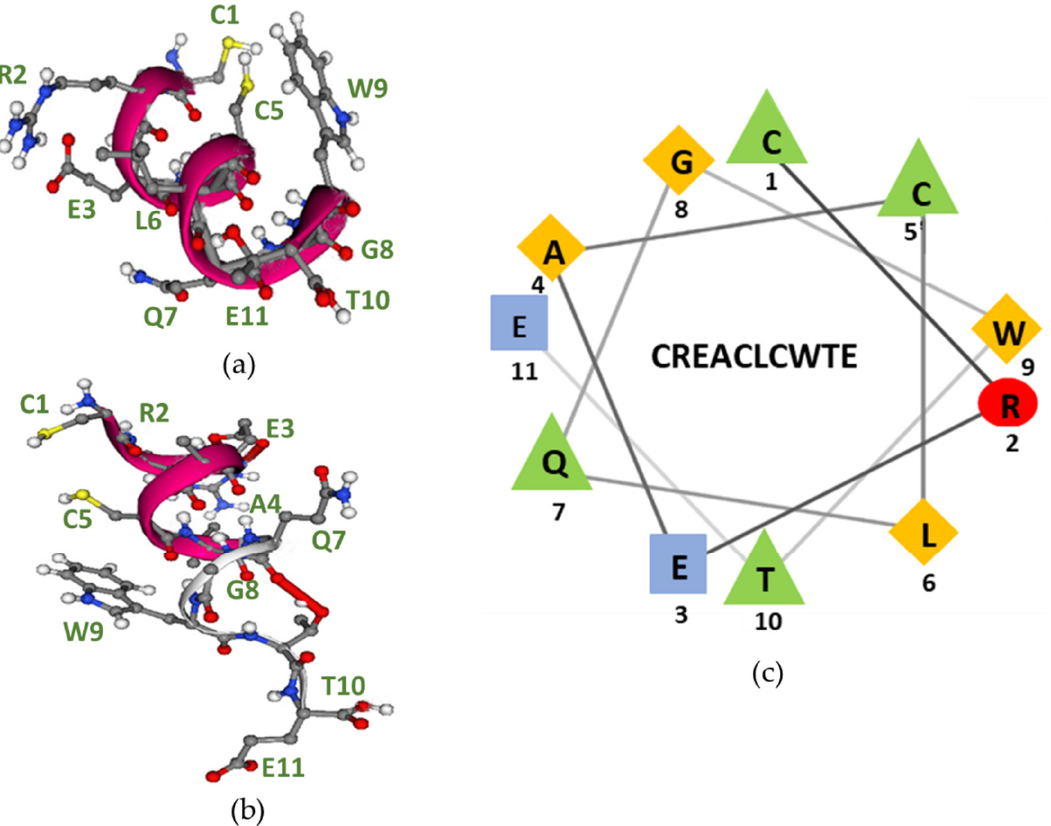
Figure 7. Structural epitope analysis. ( a ) The three-dimensional structure of the CREACLQGWTE sequence obtained from PEP FOLD SERVER. The peptide folds into an α -helix structure in which protruding amino acid residues are seen. On the right side of the structure, the side-chain residues of Trp 9 , Cys 1 , and Cys 5 protrude. On the left side of the structure, the side-chain residues of Arg 2 , Glu 3 , Leu 6 , Gln 7 , and the terminal Thr 10 protrude. ( b ) The three-dimensional structure of the CREACLQGWTE peptide. Yellow balls = sulphur atoms, red balls = oxygen atoms, grey balls = carbon atoms, white balls = hydrogen atoms, and blue balls = nitrogen atoms. ( c ) Helical wheel representation of the CREACLQGWTE peptide. The residues in the epitope are presented using one-letter codes. The image was generated using the NetWheels application (http://lbqp.unb.br/NetWheels, accessed on 14 May 2022). The following colours represent amino acid functions: red, polar/basic; blue, polar/acid; green, polar/uncharged; yellow, nonpolar.